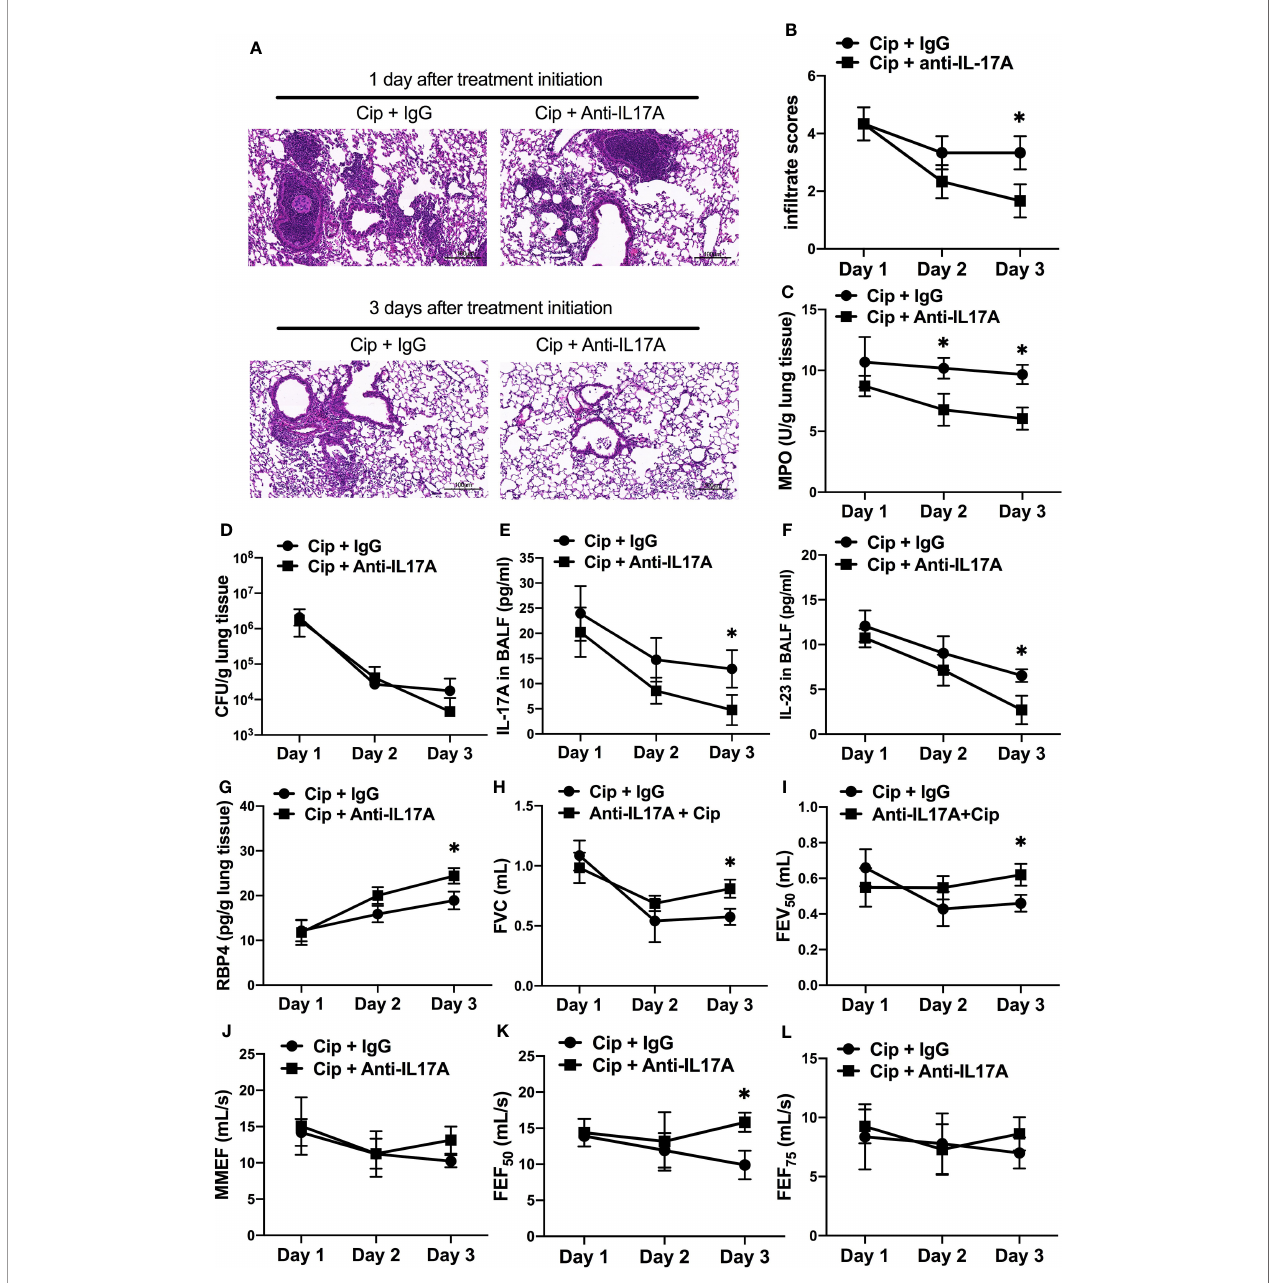
FIGURE 7 | Adjunctive therapy of IL-17A – neutralizing antibody to antibiotic improved the outcome of P. aeruginosa infection in COPD mouse models. COPD mouse models were intrabronchially inoculated with 1.0 × 10 5 CFU agar-entrapped P. aeruginosa . Oral cipro fl oxacin (5 mg/kg, every 12 h) was applied concurrently with intraperitoneally administered IL-17A – neutralizing antibody (2 mg/kg, every 4 h) or IgG starting at 16 h post inoculation. Mouse lungs were excised, sectioned and stained with hematoxylin and eosin (internal scale bar = 100 m m) after treatment (A) , and the in fi ltrate scores (B) and MPO activity (C) were determined on each day. Bacterial plate counting (D) , protein levels of IL-17A (E) , IL-23 (F) , and RBP4 (G) , and spirometry tests, including FVC (H) , FEV 50 (I) , MMEF (J) , FEF 50 (K) , and FEF 75 (L) , were performed and compared between groups treated with and without IL-17A block. Data are representative of three independent experiments, and are presented as mean ± SD ( n = 3 per group). * P < 0.05. COPD, chronic obstructive pulmonary disease; Cip, cipro fl oxacin; CFU, colony-forming units; MPO, myeloperoxidase; FVC, forced vital capacity; FEV50, volume expired in the fi rst 50 ms of fast expiration; MMEF, maximal mid-expiratory fl ow; FEF 50 , forced expiratory fl ow at 75% fl ow at 50% FVC; FEF 75 , forced expiratory